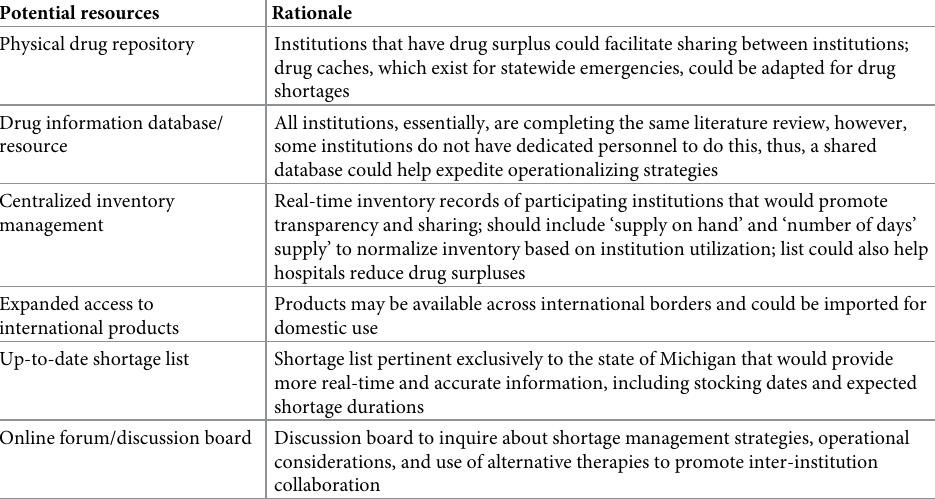
Table 3. Collaborative resource